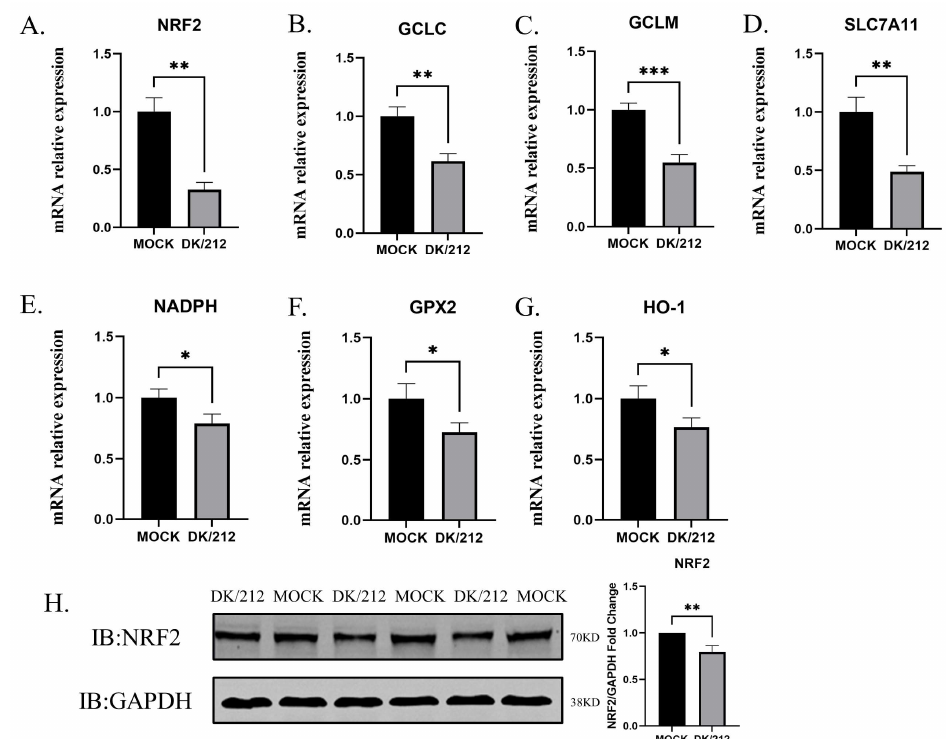
Figure 2. Relative expression levels of antioxidant genes in A549 cells at 24 hpi with H5N1 avian influenza virus. RNA was extracted from A549 cells at 24 hpi. The mRNA expression levels were analyzed by qPCR. GAPDH was used as loading control. The relative expression of ( A ) NRF2, ( B ) GCLC, ( C ) GCLM, ( D ) SLC7A11, ( E ) NADPH, ( F ) GPX2, ( G ) HO-1 were detected by real-time RT-PCR. ( H ) Changes in NRF2 protein expression in A549 cells 24 hpi. All data were expressed as means ± SD, the Student’s t- test was used to analyze the differences. (* p < 0.05, ** p < 0.01, and *** p < 0.001).